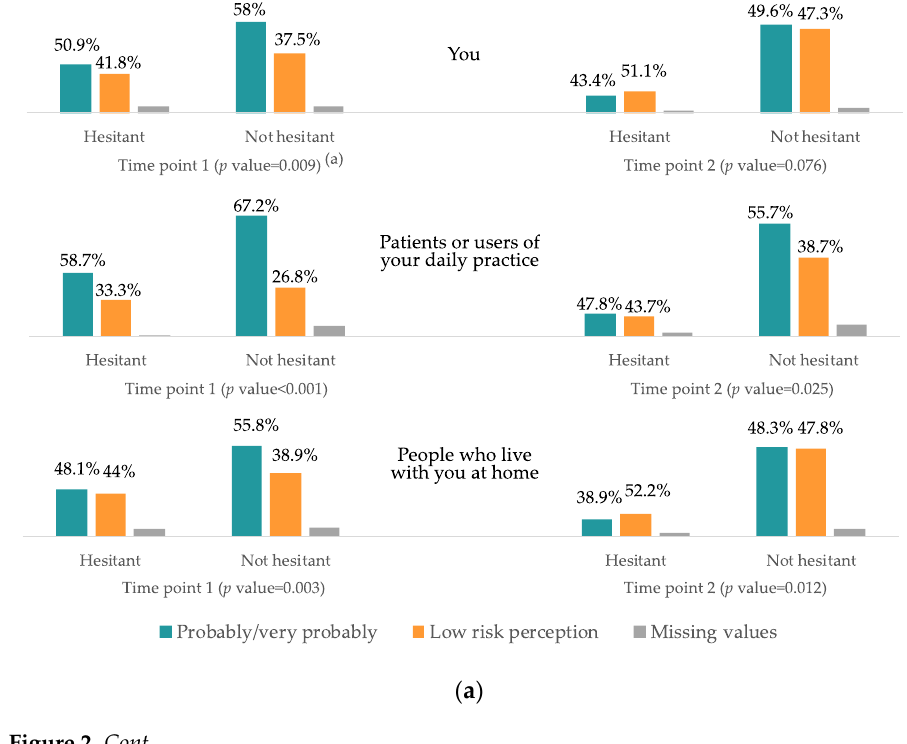
( b ) Figure 2. ( a ) Disease’s perception of risk: probability of infection, by hesitancy and time period. COVID-19 Vaccine Hesitancy Study. Barcelona. 2020-2021. ( a ) Chi square test between hesitant and non-hesitant nurses does not include missing values. Chi square test between time points were